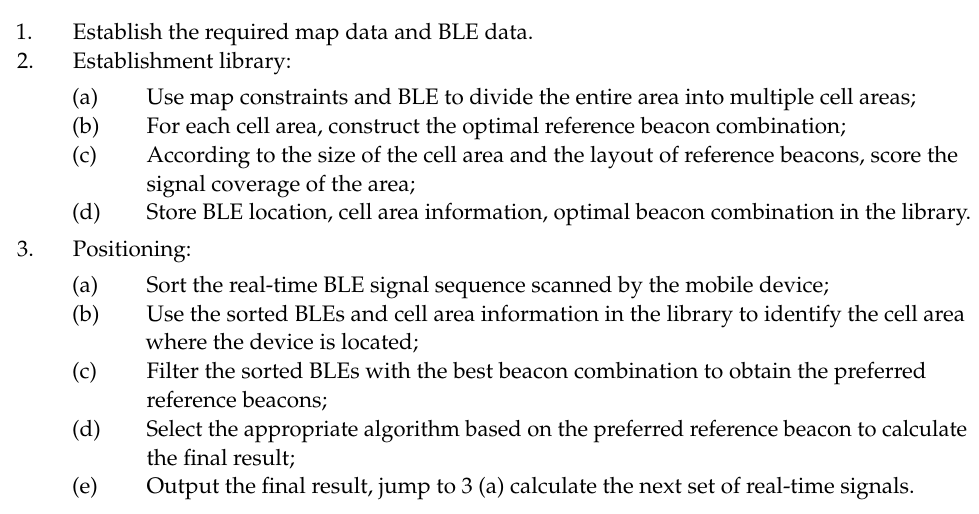
Algorithm 1 Proposed localization